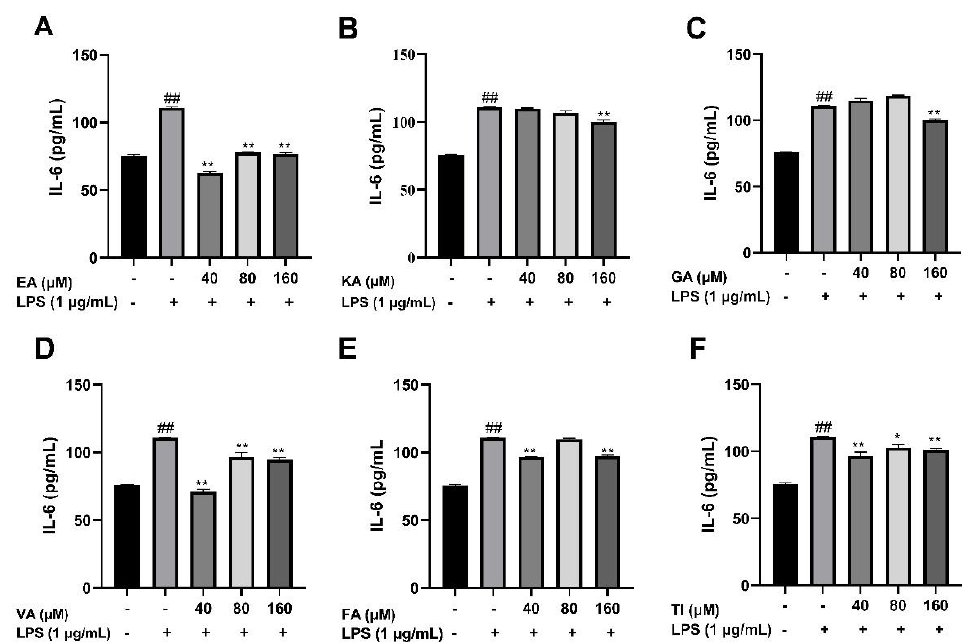
Figure 17. Effects of Ellagic acid ( A : EA), Kaempferol-3-o-rutin glycoside ( B : KA), Gallic acid ( C : GA), Vanillic acid ( D : VA), Ferulic acid ( E : FA), and Tiliroside ( F : TI) on LPS-induced IL-6 in BV2 cells at high (160 µ M), medium (80 µ M) and low (40 µ M) concentrations. − indicates that contain, + indicates does not contain. ## represent significant difference between the representative model group and the control group. * represents significant difference compared with model group ( p < 0.05); and ** represents extremely significant difference compared with model group ( p < 0.01).